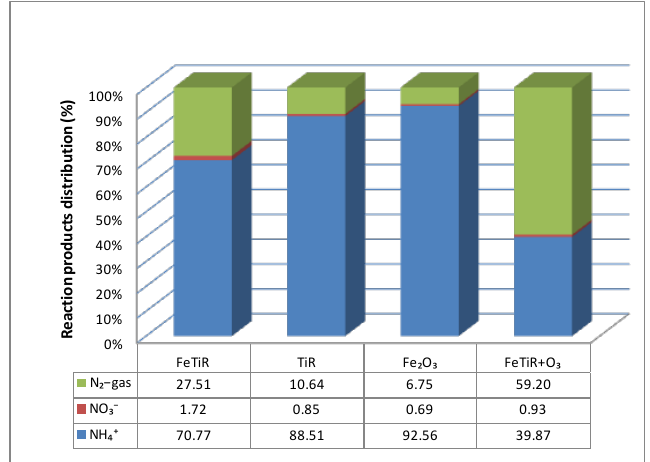
Figure 15. Reaction products distribution for aqueous ammonia photo-oxidation and ozone photo- assisted process (carried out for FeTiR catalyst).